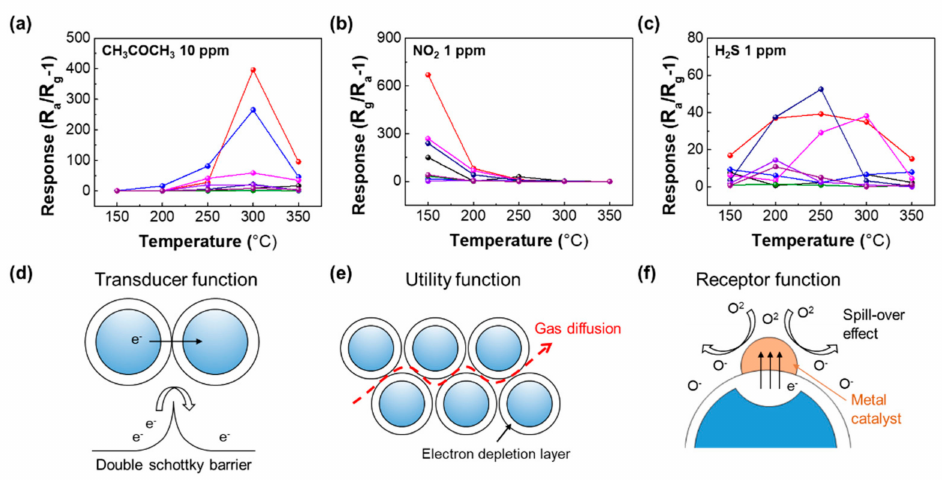
Figure 5. Response of the 2 × 4 sensor array to ( a ) 10 ppm CH 3 COCH 3 , ( b ) 1 ppm NO 2 , and ( c ) H 2 S 1 ppm vs. the wide range of operating temperatures from 150 to 350 ◦ C. ( d ) Transducer function, ( e ) utility function, and ( f ) receptor function and spill-over effect that represent gas mechanisms.